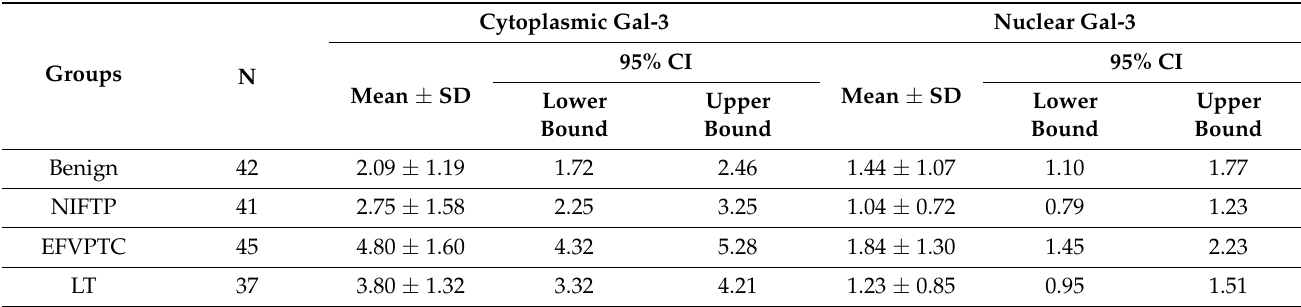
Table 2. Gal-3 expression level in cytoplasm and nucleus in tissues from Benign, NIFTP, EFVPTC and Lymphocytic thyroiditis (LT).